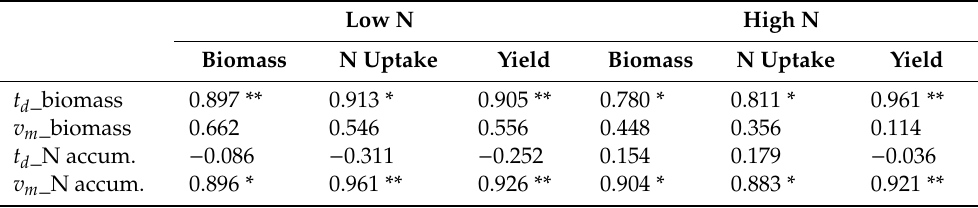
Table 5. Pearson correlation matrix between crop biomass, N uptake and yield in three oilseed rape cultivars with the growth dynamic characteristics at low and high N rate during the 2014–2015